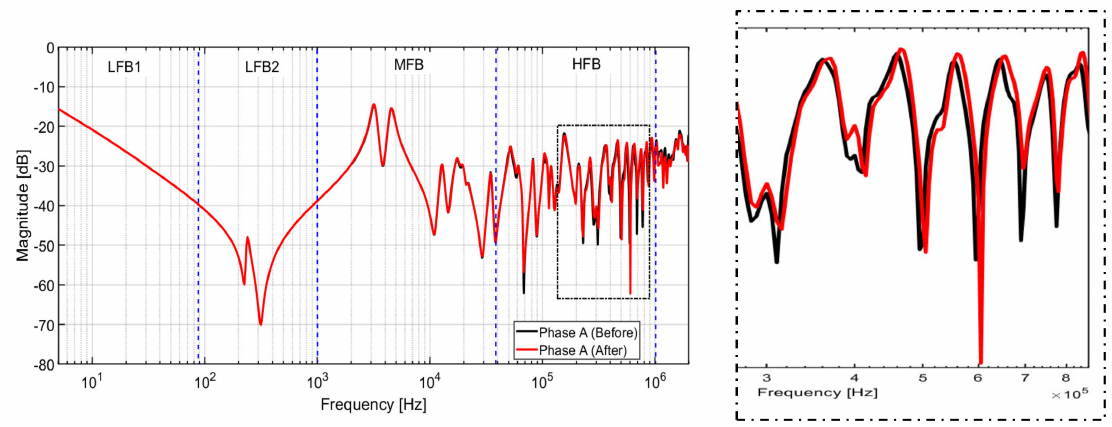
Figure 23. TF of LV winding before and after axial collapse [24].